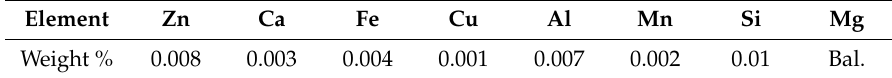
Table 1. Chemical composition of magnesium.